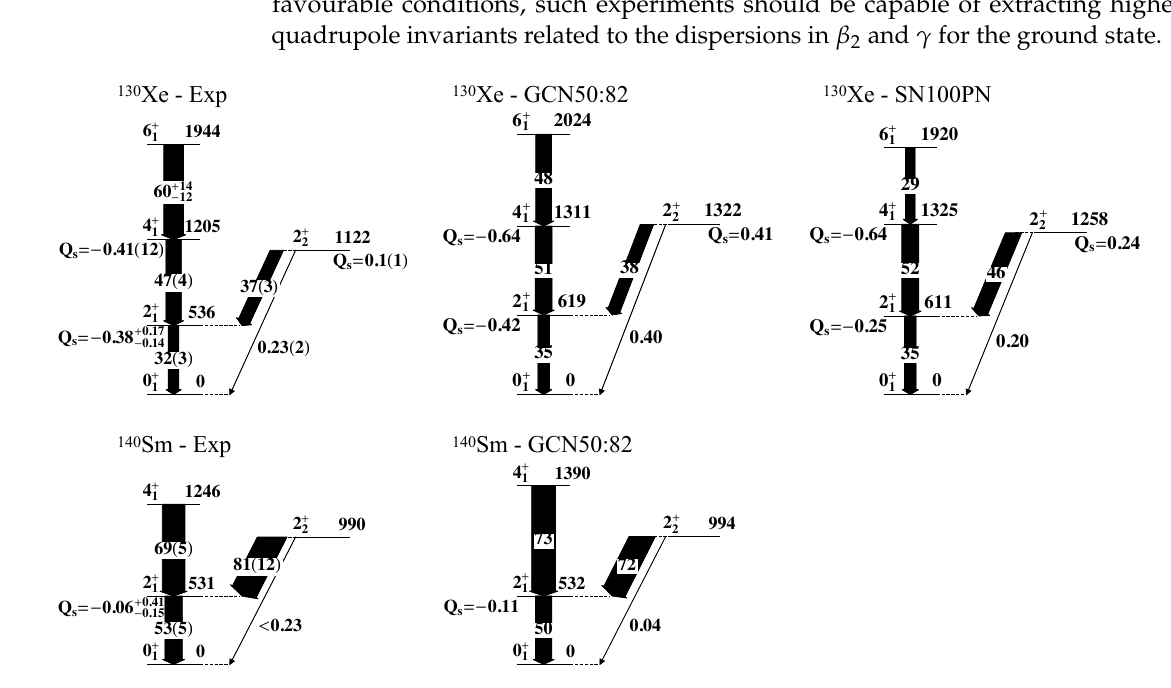
Figure 5. Comparison of low-energy parts of the experimental 130 Xe and 140 Sm level schemes with Shell-Model calculations using GCN50:82 and SN100PN interactions [16,72]. The states are labelled with their spin and parity I π and excitation energy in keV. Transitions are labelled with reduced transition probabilities expressed in Weisskopf units. Spectroscopic quadrupole moments are reported in e b. See text for further details about the